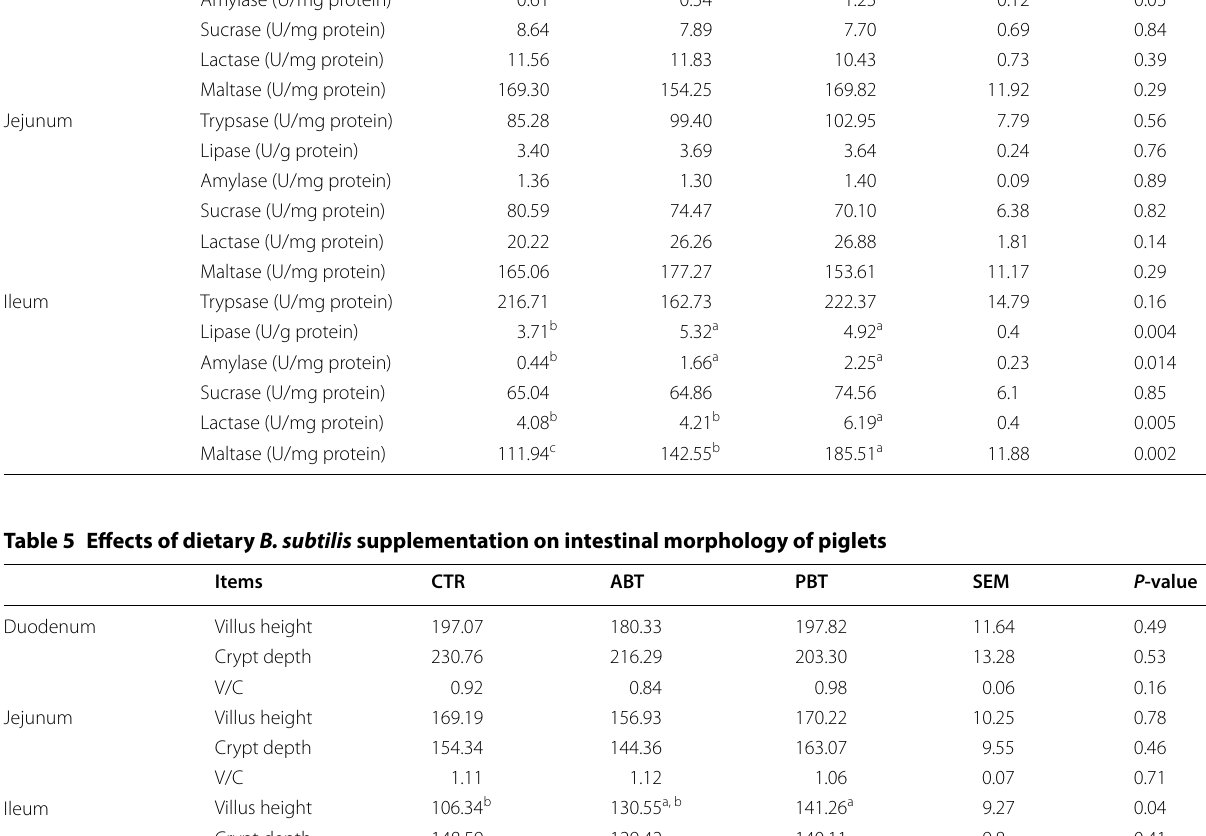
V/C villus height/crypt depth